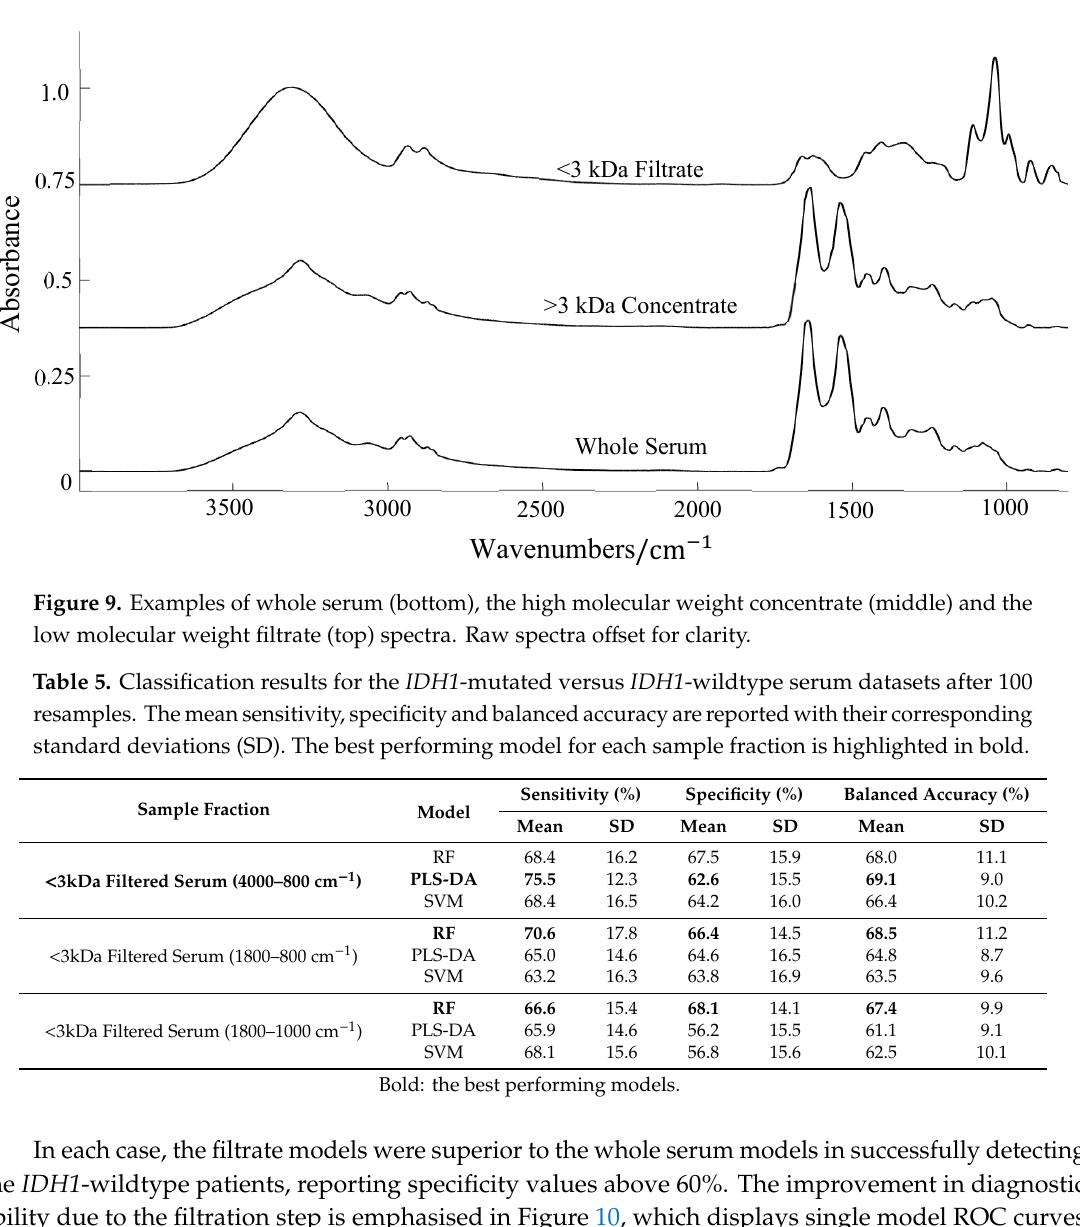
standard deviations (SD). The best performing model for each sample fraction is highlighted in